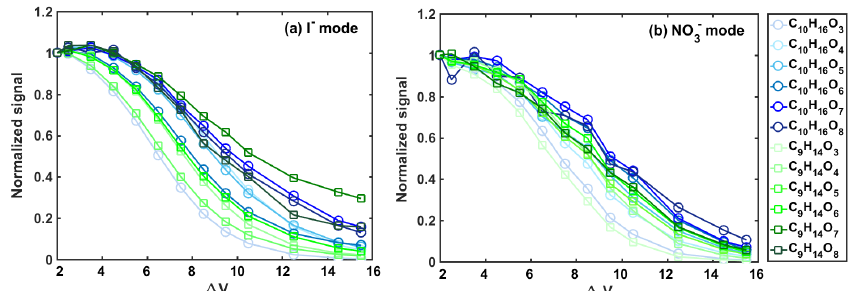
Figure 12. Declustering scans of products C 10 H 16 O 2 − 8 and C 9 H 14 O 3 − 8 formed by the ozonolysis of α -pinene in (a) I − and (b) NO − modes. (cid:49)V denotes the voltage differences between the end of first and the entrance to the second quadrupole sections of the mass spec- trometer. Signals at each (cid:49)V are normalized to that obtained at the weakest declustering strength (i.e., (cid:49)V = 2V).